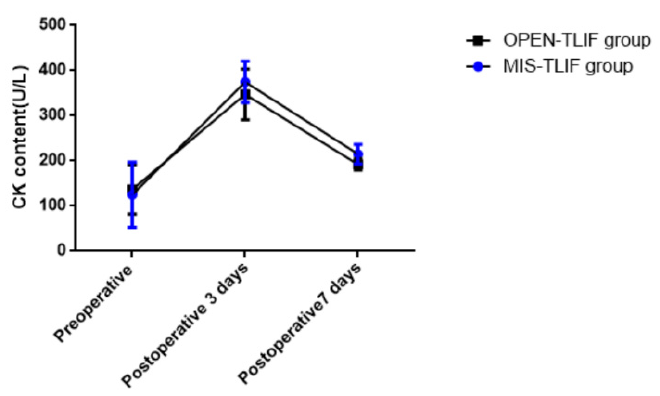
Figure 2. Changes of perioperative CK content in MIS-TLIF and Open-TLIF groups.